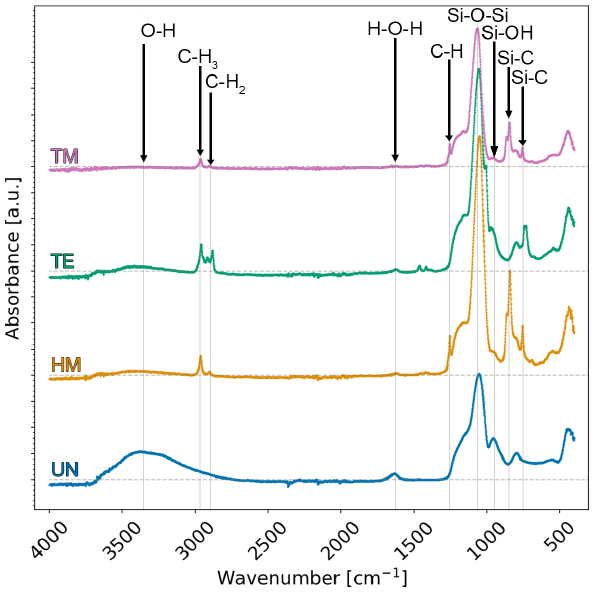
Figure 2. ATR-FTIR spectra were collected on the unmodified UN (blue), hexamethyldisilazane- modified HM (orange), triethylchlorosilane-modified TE (green), and trimethylchlorosilane-modified TM samples (pink) after APD. The modified samples showed typical bands for silylation. The carbon and hydrogen content measurements were used to quantify the organic part of the surface modification. Accordingly, the elemental analysis with the measured weight percentage wt% of hydrogen and carbon, as well as an equivalent amount of sub- stance mol* in an arbitrary amount of 100 g is summarized in Table 1. Here, the carbon and hydrogen content was noticeably higher for the silylated gels in comparison to the unmodified sample. This is to be expected, as the surface modification introduces carbon- and hydrogen-containing groups (i.e., -CH 3 , -CH 2 CH 3 ) to the material surface (Figure 1). As expected, the TE sample showed the highest carbon and hydrogen content, as this sample had ethyl instead of methyl end groups attached. Contrary to the FTIR measure- ments, the results suggest that there was only a slight difference in surface modification for the TM and HM samples, assuming that the carbon content only arose from the silyla- tion agents. According to the literature, the reactivity of HM should be lower because of the change in pH during the synthesis, as well as a possible two-step reaction [27]. This might be in the range of the resolution of the elemental analysis. Furthermore, all samples showed an undetectable nitrogen content, confirming that the HMDS reacted, as shown in Figure 1, leaving no nitrogen traces inside the HM specimen. Unexpectedly, the carbon content was roughly 1 wt% for the unmodified sample, as only silanol end groups should be present in this material, which could be indicative of residual organic chains of the used solvent. Alternatively, this suggests that the ethoxy end groups of the TEOS precursor remained during the sol-to-gel transformation, and the hydrolysis was incomplete. Con- sidering that this is the only source of carbon content, this would mean for the UN sample that ca. 0.23 mol* of the hydrogen content originated from the ethoxy group (-OC 2 H 5 ). The rest of 1.19 mol* would come from adsorbed water (H 2 O) or silanol (-OH) end groups. For simplicity, it may be assumed that the amount of unhydrolyzed TEOS would be identical throughout the different samples, in which case the calculated carbon and hydrogen val- ues of the UN sample could be subtracted from the other specimens. This would result in a carbon content of 1.09 mol*, 1.32 mol*, and 1.09 mol*, as well as a hydrogen amount of 3.42 mol*, 3.47 mol*, and 3.21 mol* for the HM, the TE, and the TM samples, respectively. Considering a successful surface modification with only methyl end groups (-CH 3 ) for the